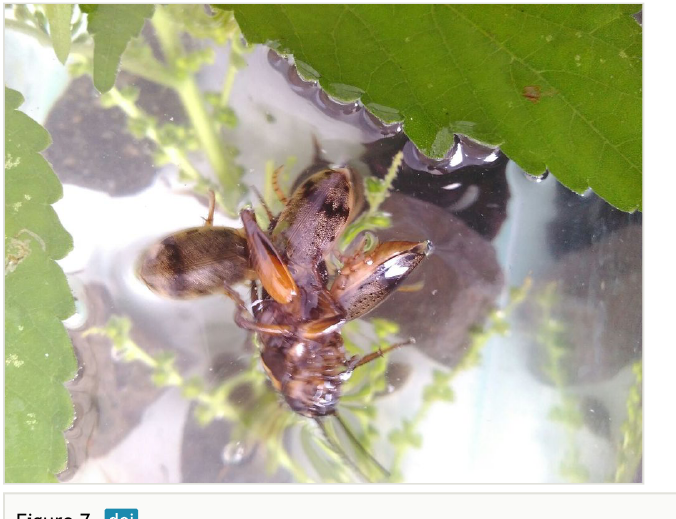
Figure 7. Eretes griseus , HP image from Bali.